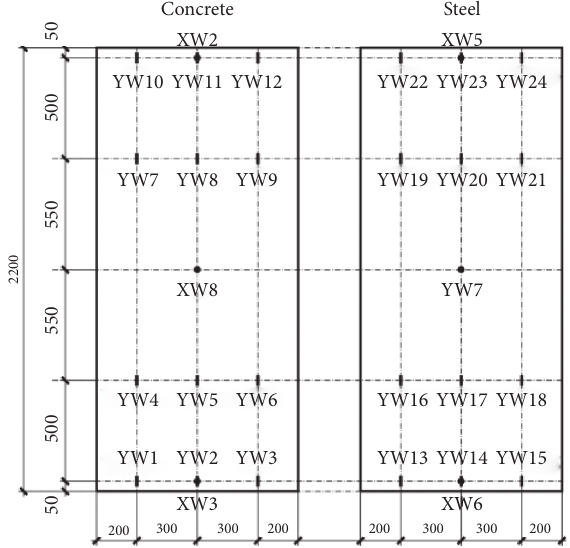
Figure 21: Arrangement of displacement measuring points for compressive experiment specimens.